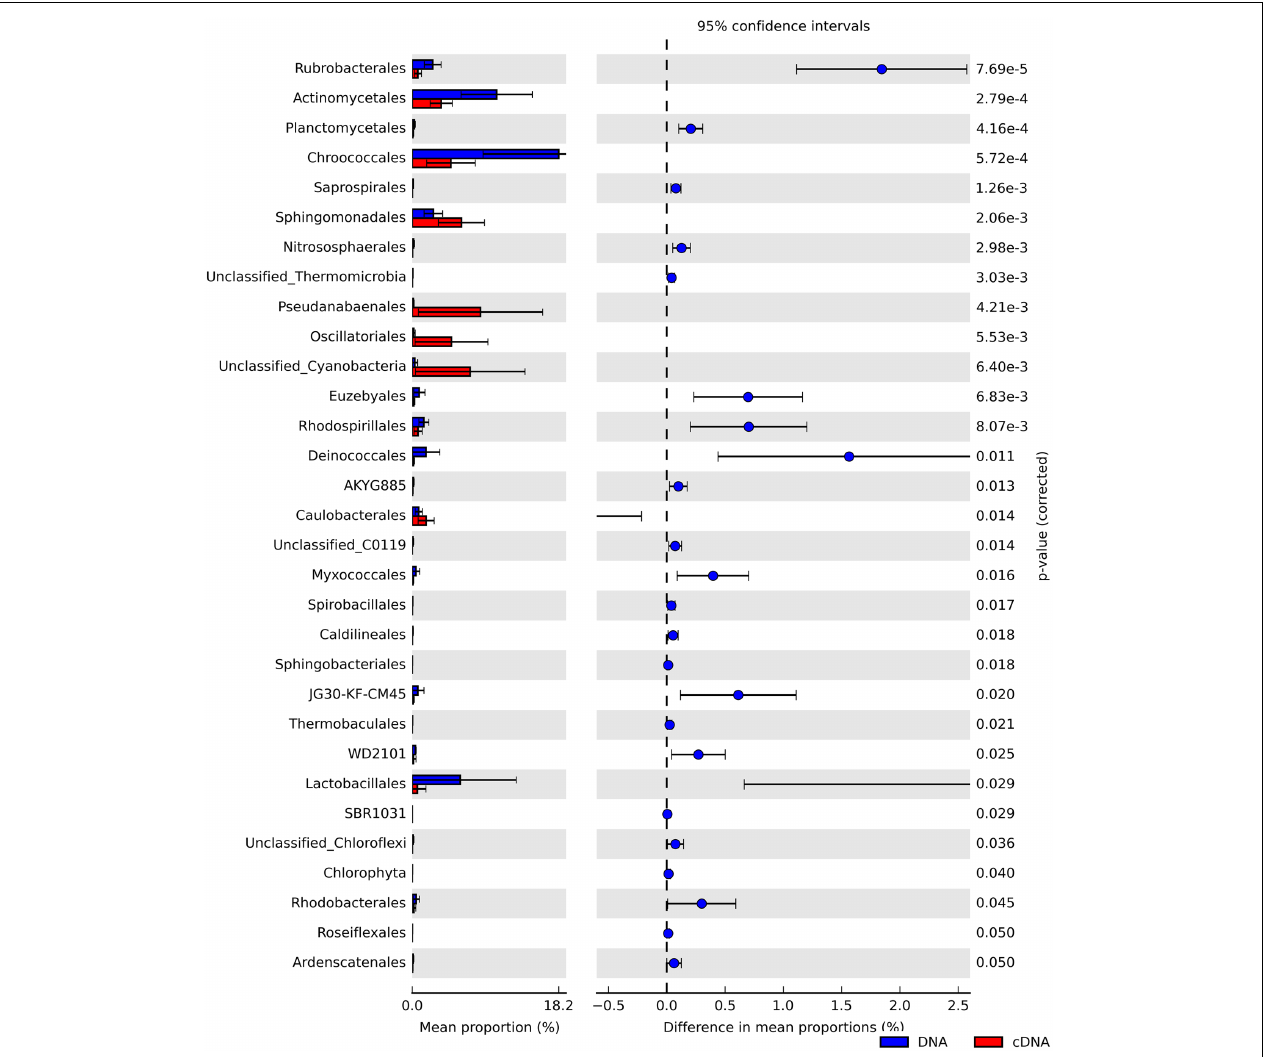
FIGURE 3 | Extended bar charts showing significant differences in the relative abundances of taxa at the order level between the total (DNA, blue) and potentially active (RNA, red) hypolithic